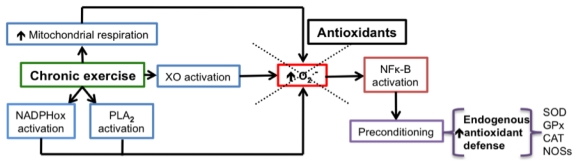
Chronic exercise increases the production of superoxide radical (O2.−) through the increase of mitochondrial respiration and activation of NADPH oxidase (NADPHox), phospholipase A2 (PLA2) and xanthine oxidase (XO). The superoxide radical activates Nuclear Factor κ-B (NFκ-B), which in turn produces preconditioning (increase of the endogenous antioxidant defense), characterized by the increased gene expression and activity of superoxide dismutase (SOD), glutathione peroxidase (GPx), catalase (CAT) and nitric oxide synthases (NOSs). Antioxidants interfere with the effects of chronic exercise. More details are in references [34–39,41–43].